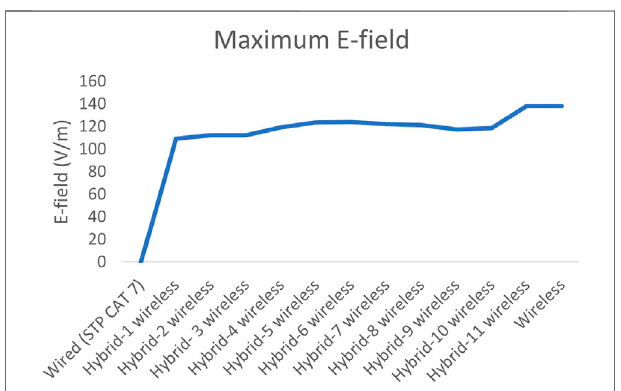
FIGURE 11 | Maximum E- fi eld generated in the solution domain for the different